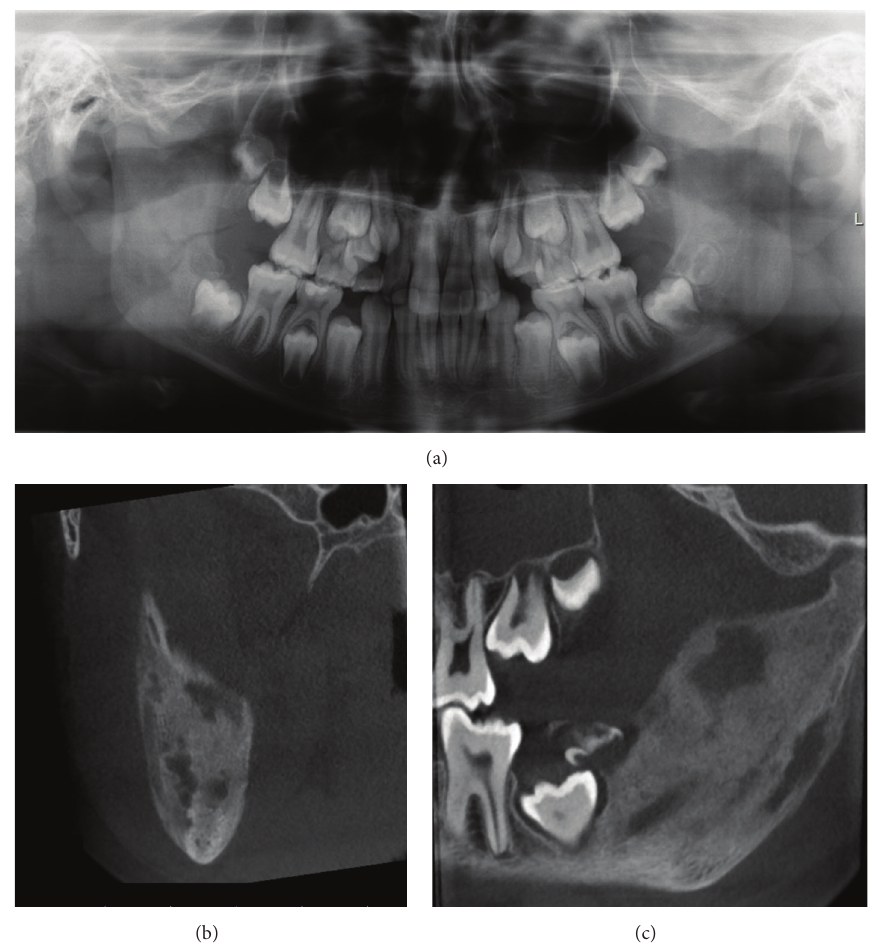
Figure 5: Preoperative radiographs and CBCT of patient case 2 with PCO. (a) Panoramic radiograph; (b and c) CBCT. Coronal and sagittal sections of sclerotic mandible with new bone formation and lytic lesions at the right posterior